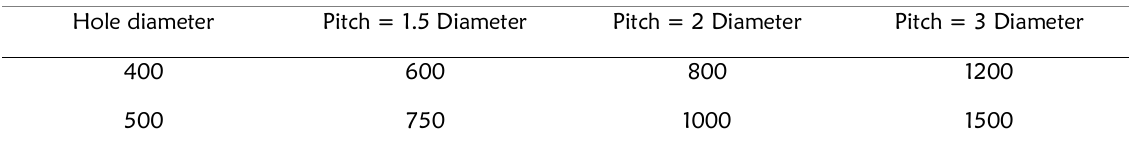
Table 1: The design criteria for two different diameters with three pitches for the hybrid surface to evaluate the best ratio to enhance the water collection